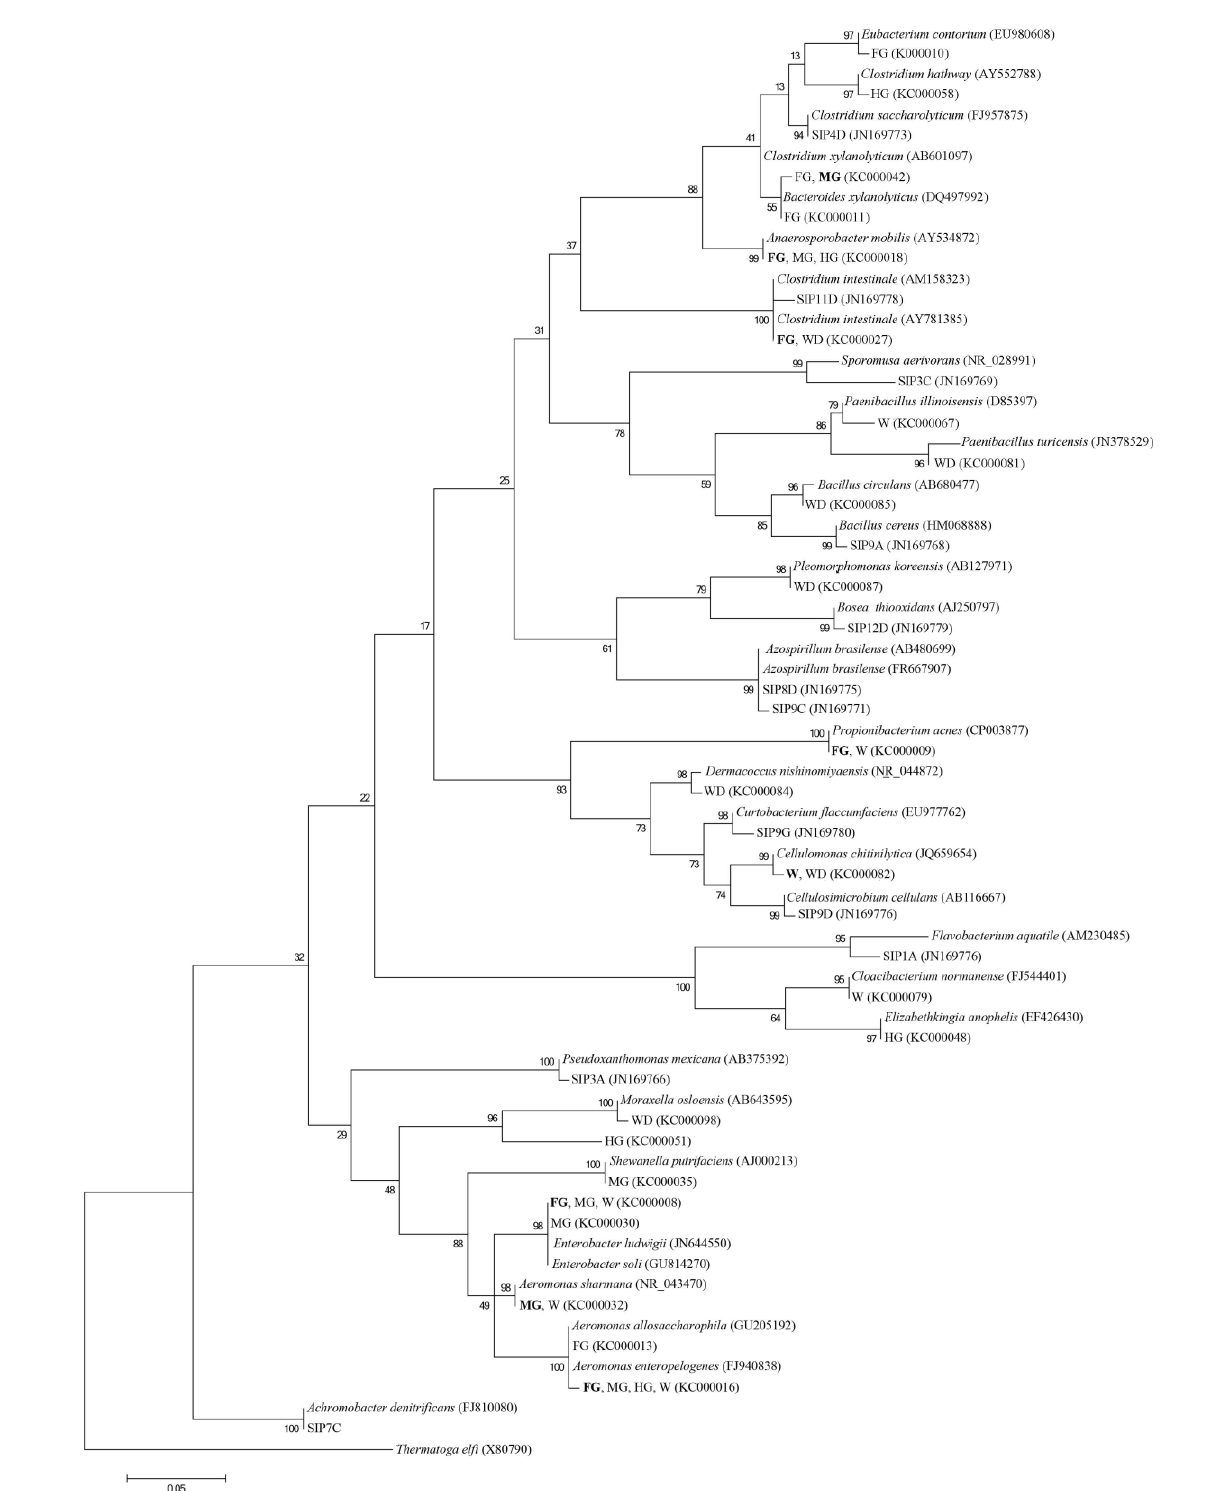
Figure 2. Phylogenetic tree showing the relationship of 16S rRNA gene sequences (>1.2 kb) identified in the cellulose enrichment culture and DNA-SIP clone